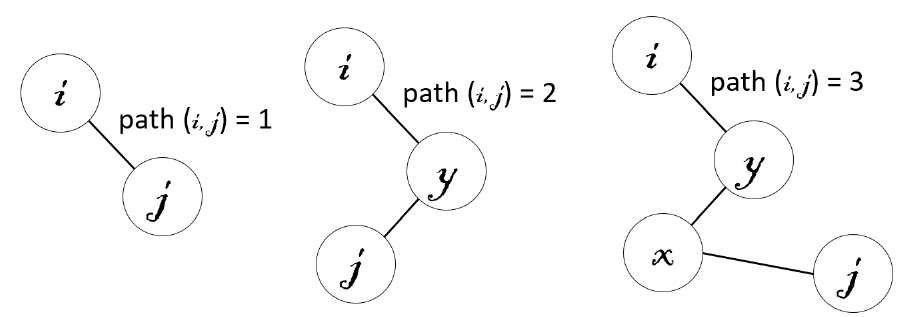
Figure 10. Graphical illustration of the three path concepts